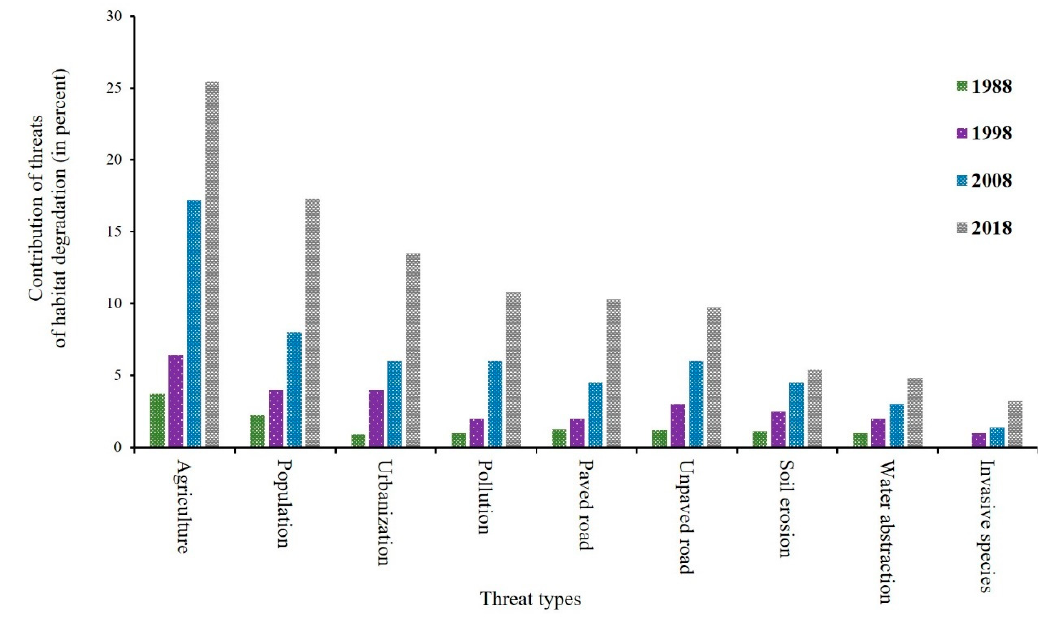
Figure 8. Threat types and their contribution to habitat degradation.